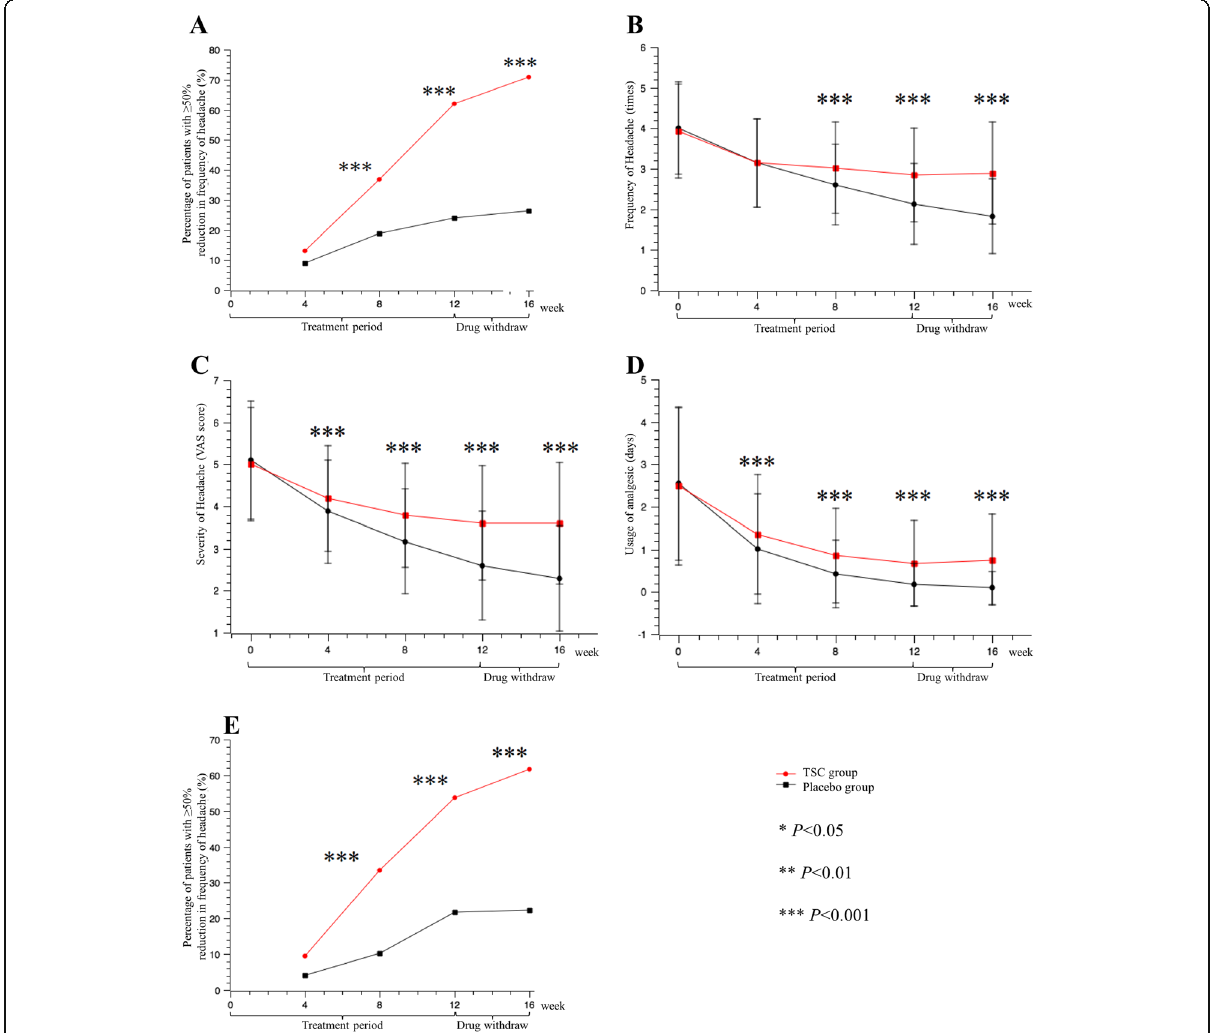
Fig. 1 Primary and secondary outcome measures in the full analysis set (FAS). a : Percentage of patients with ≥ 50% reduction in frequency of headache; b : Frequency of headache; c : Severity of headache; d : Usage of acute analgesics; e : Percentage of patients with ≥ 50% reduction in severity of headache. The percentage of patients with ≥ 50% reduction in frequency of headache ( a ) increased gradually in the TSC group and was significantly different from the placebo group at week 8 (*** P <0.001). The frequency of headache ( b ) in the TSC group was significantly lower than in the placebo group after 8weeks of treatment (*** P <0.001). The severity of headache ( c ) and usage of acute analgesics ( d ) were significantly lower in the TSC group than those in the placebo group after 4weeks of treatment (*** P <0.001). The percentage of patients with ≥ 50% reduction in headache severity (e) was significantly increased in the TSC group compared with the placebo group after 8weeks of treatment (*** P